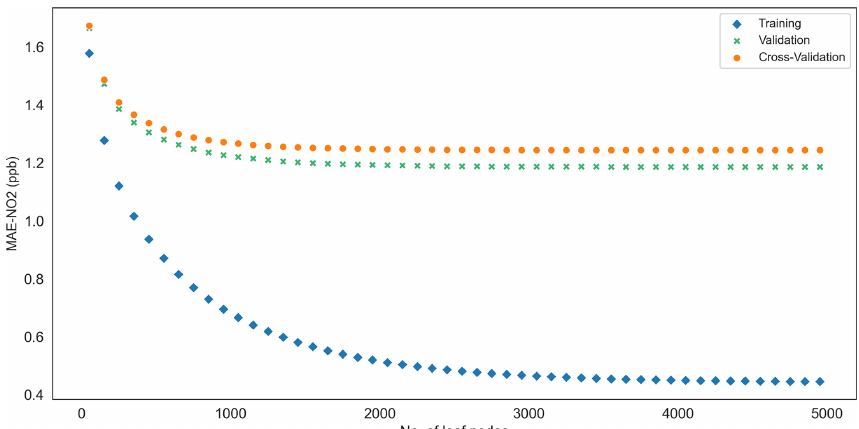
Figure 3. NO 2 RFR model performance returns with increasing model complexity (maximum number of leaf nodes included in training, validation and cross-validation